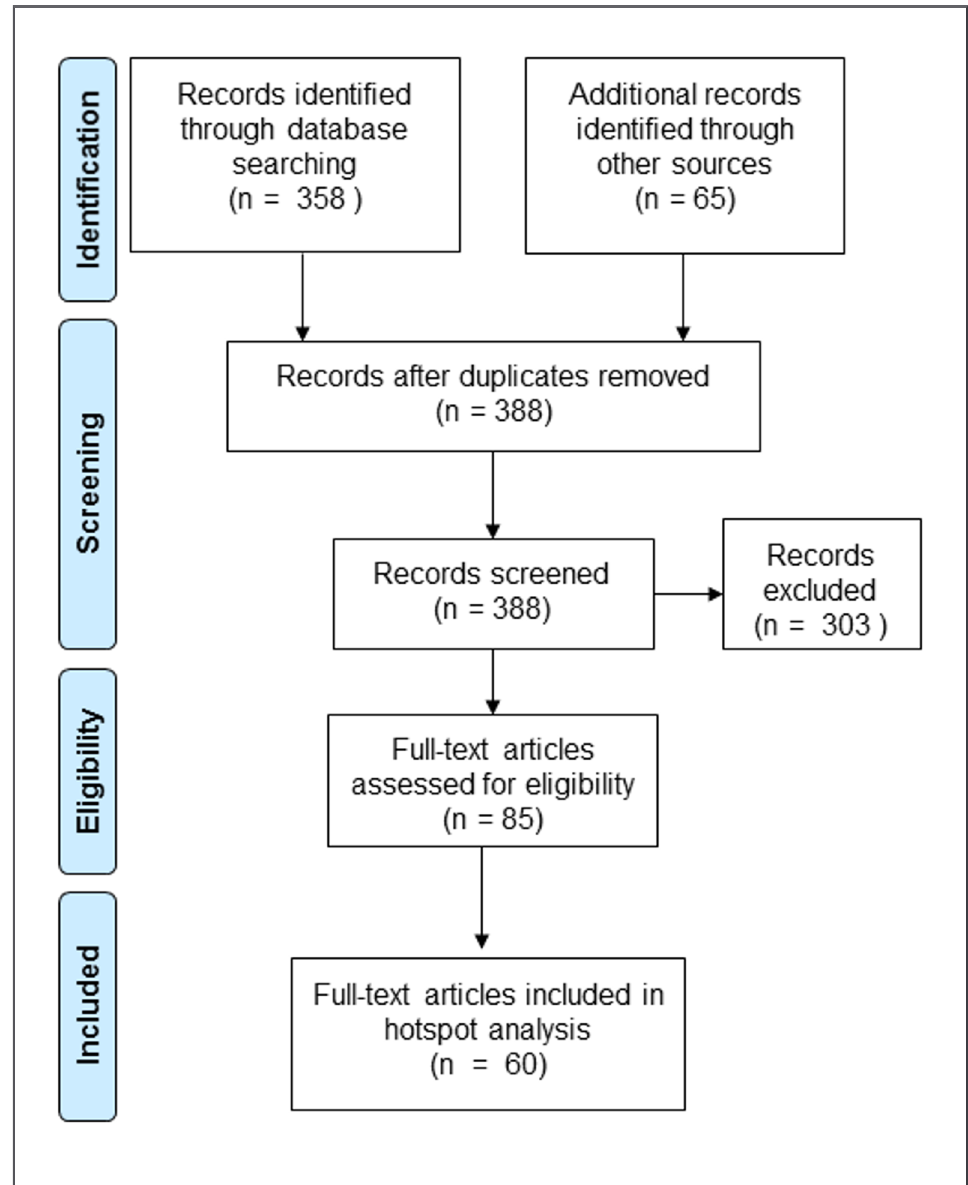
Fig 1. Procedure for the selection of studies of mammalian carnivores in Peninsular Malaysia with records collected during 1948–2014.